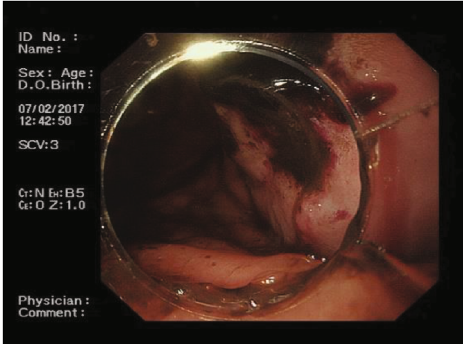
Figure 3: The distal end of the tumor was in the stomach where a large amount of old accumulated blood was found. Bleeding ulcerations were observed on the surface of the